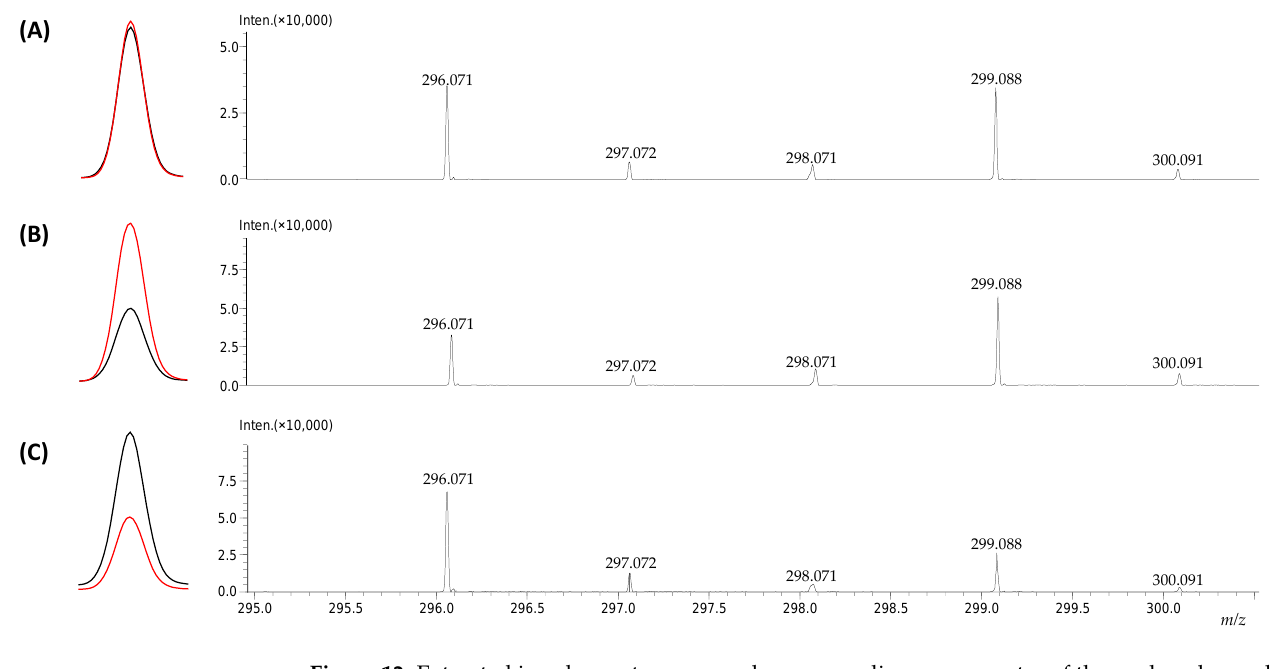
Figure 12. Extracted ion chromatograms and corresponding mass spectra of the analyzed samples containing armodafinil (black line) and armodafinil-d 3 (pink line) mixed in ( A ) 1:1 ratio ( B ) 1:2 ratio, ( C ) 2:1 ratio.